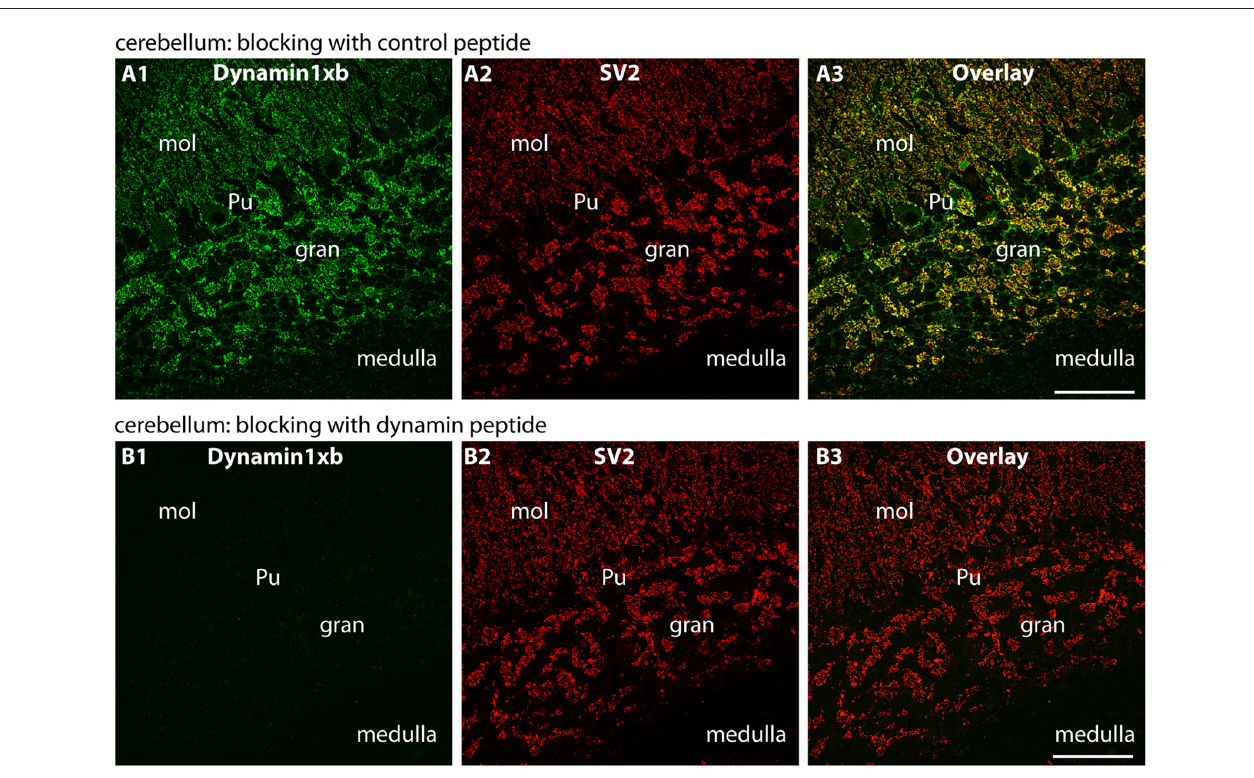
FIGURE 6 | Semi-thin (0.5 µ m-thin) sections of the mouse cerebellum immunolabeled with the monoclonal dynamin1xb antibody that was pre-absorbed either with a control peptide (A) or with the dynamin1xb peptide “PP12” against which the monoclonal antibody was raised (B) . The strong dynamin1xb immunosignal in the synaptic regions of the cerebellar cortex was completely absent if the antibody against dynamin1xb was pre-absorbed with “PP12” whereas the synaptic dynamin1xb immunolabel is completely unaffected if a control peptide was used. The SV2 control immunolabeling was completely unaffected by both of these treatments. Figure 6 was obtained by confocal microscopy. Abbreviations: mol, molecular layer; Pu, Purkinje cell layer; gr, granule cell layer. Scale bars: 30 µ